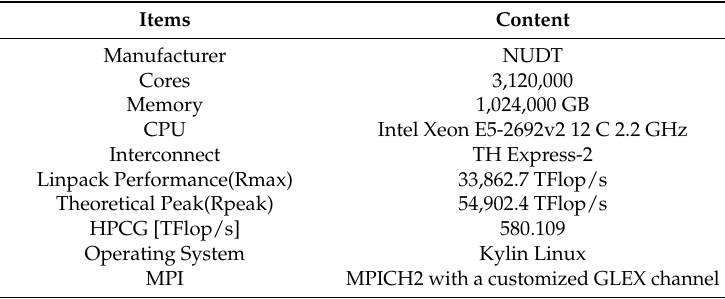
Table 1. The system configuration of